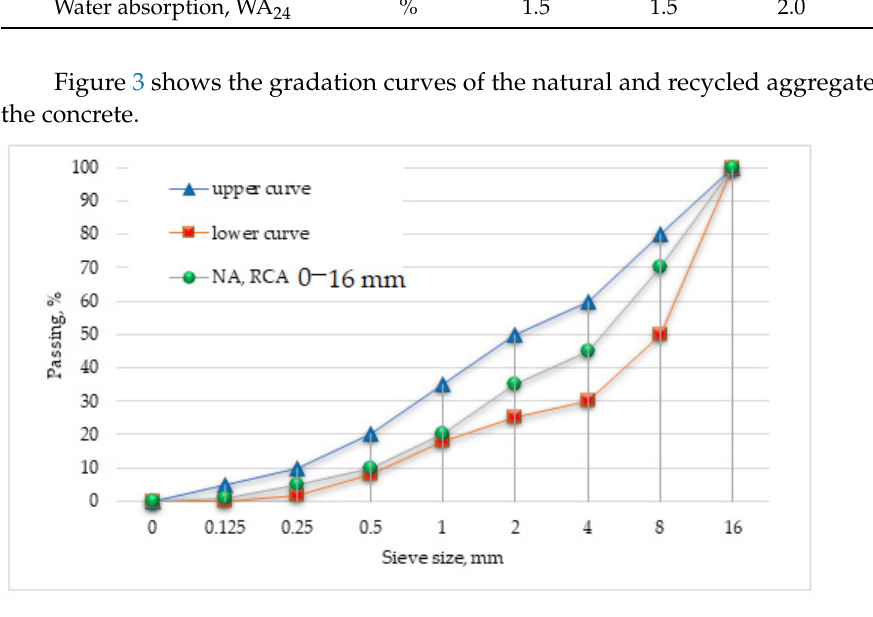
Figure 3. Gradation curves of the NA and RCA.